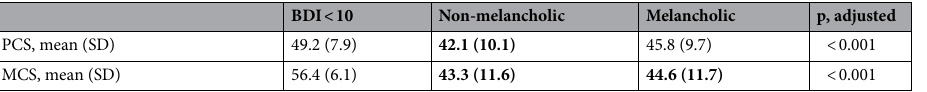
Table 2. Association between the physical and mental components of health-related quality of life (HRQoL) and type of depressive symptoms. Model adjusted for age, sex and population stratification, smoking, alcohol usage, socioeconomic class, body mass index, leisure-time physical activity and comorbidities. BDI Beck Depression Inventory, PCS physical component score, MCS mental component score, SD standard deviation. P values were based on the bootstrap style method of 10,000 repetitions.